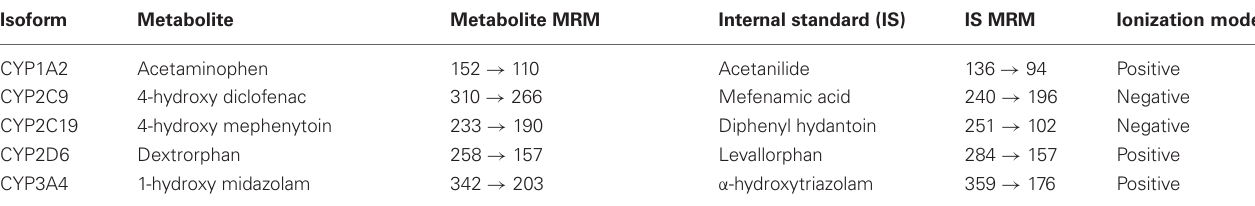
Table A5 | Specific multiple reaction monitoring (MRM) transitions monitored to quantify the analyte of interest were as follows.